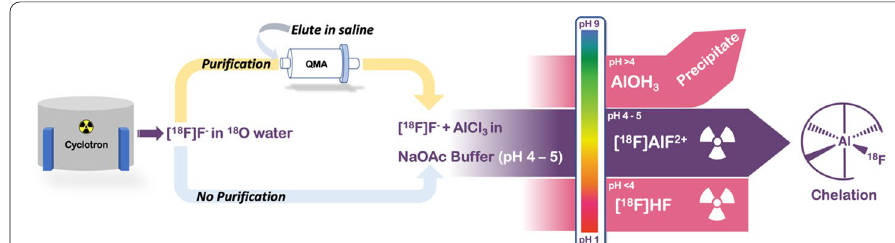
Fig. 2 Schematic representation of the process for efficient [ 18 F]AlF 2 + complex formation and subsequent chelation from nucleophilic [ 18 F]F − in 18 O water